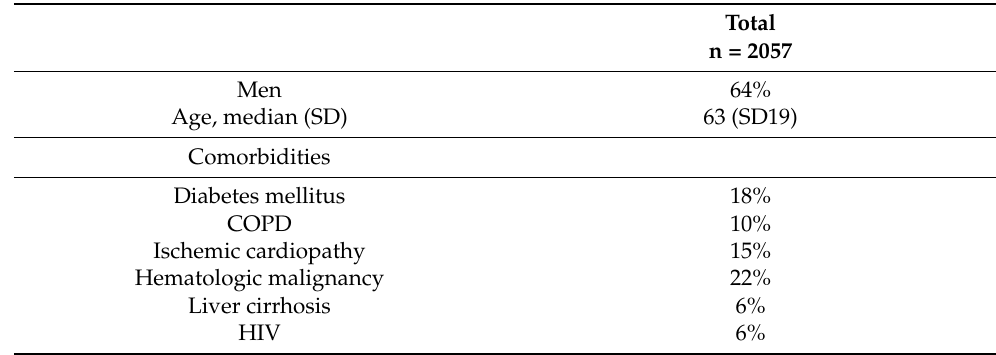
Table 1. Demographics and clinical characteristics of the cases with P. aeruginosa BSI and their